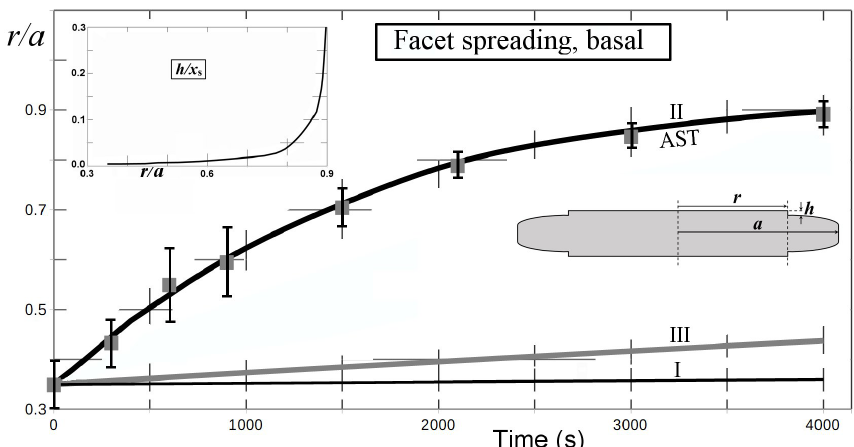
Figure 6. Facet spreading of basal from Fig. 5 (solid gray squares, error bars) with model fits I–III from Appendix A (curves). (I) Normal growth of the facet edge. (II) Facet spreading from AST. (III) Normal growth of the rough, rounded region. Assumed supersaturation of 1% and temperature of − 30 ◦ C. For calculation details, see Appendix A. Crystal radius a is the mean value out to the prism–prism edge. Hatch marks are truncated grid lines. Inset plot shows values of facet-edge height h used in the fit for case II; x s is the surface migration distance. Inset sketch shows cross section and basal faces top and bottom, with plotted variables.